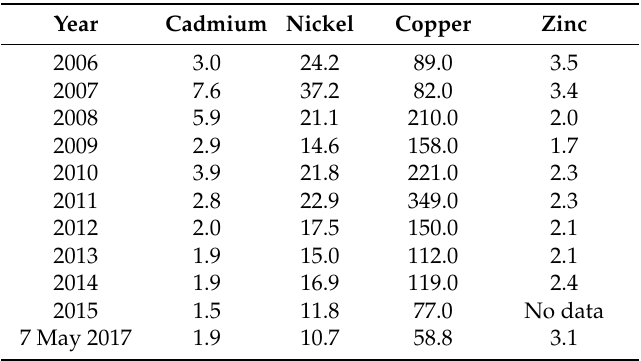
Table 4. Development of market prices [$ kg − 1 ] for several non-ferrous metals [27,28]; prices as of 7 May 2017: Shanghai Metal Exchange